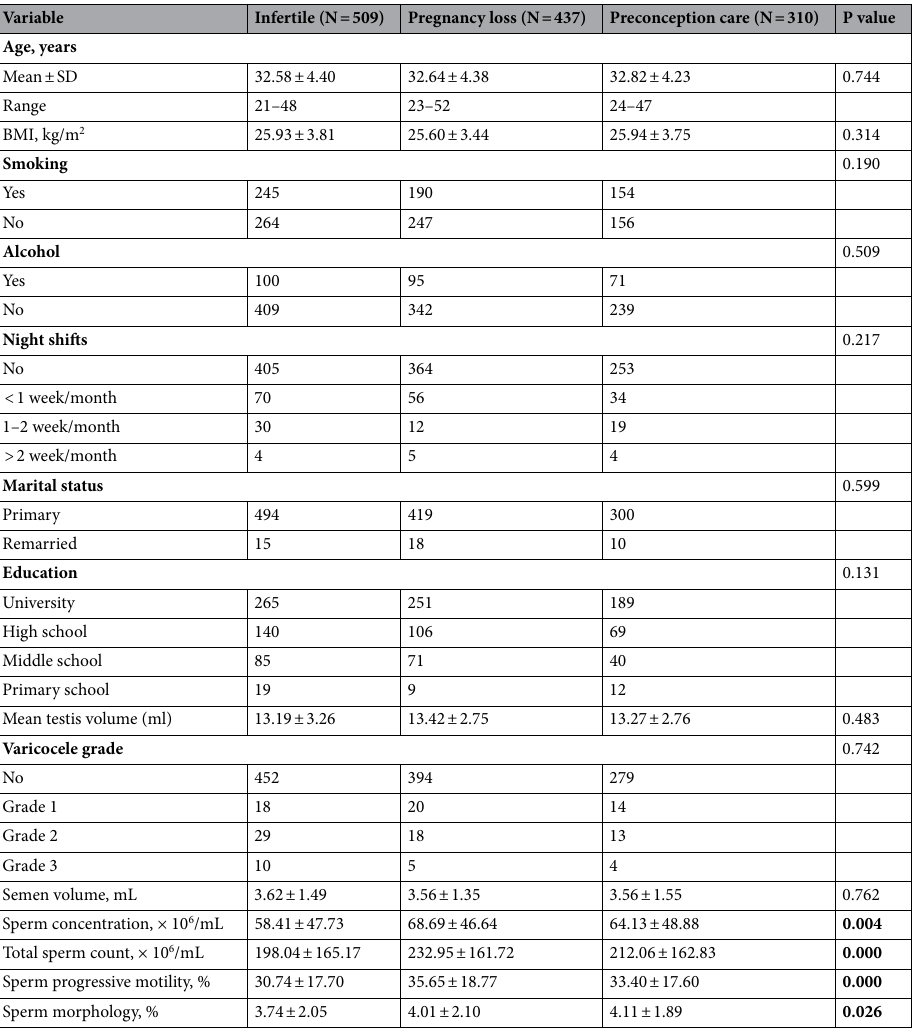
Table 1. Sociodemographic and main clinical characteristics of included individuals. Datas were expressed as mean ± standard deviation or number (percentage), when appropriate. Datas were assessed with one-way ANONA or Chi-square test, when appropriate. BMI body mass index. Significant values are in